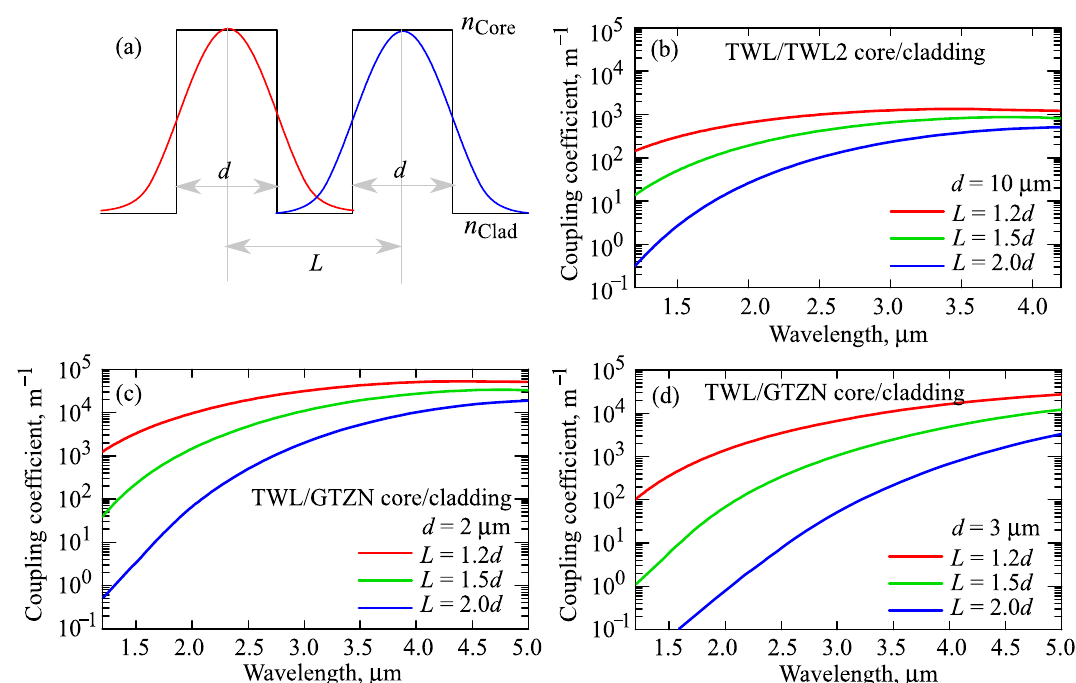
Figure 5. Schematic diagram demonstrating mode field overlapping in a two-core fiber ( a ). Calculated coupling coefficients for two-core fibers with different L / d ratios for TWL/TWL2 core/cladding, d = 10 µ m ( b ); TWL/GTZN core/cladding, d = 2 µ m ( c ); TWL/GTZN core/cladding, d = 3 µ m ( d ).